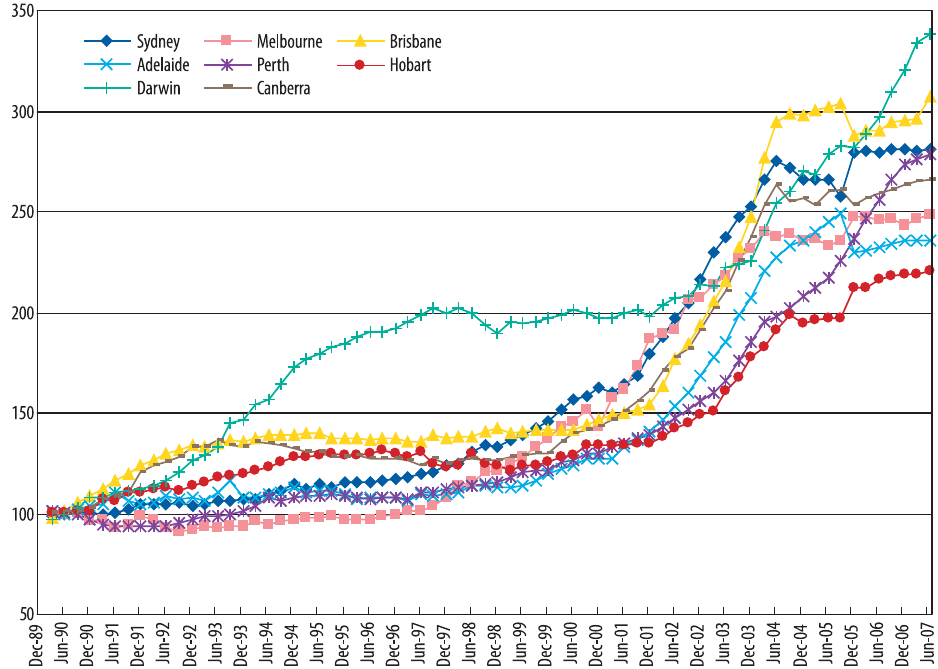
Figure 1. House price indices in Australia’s eight capital